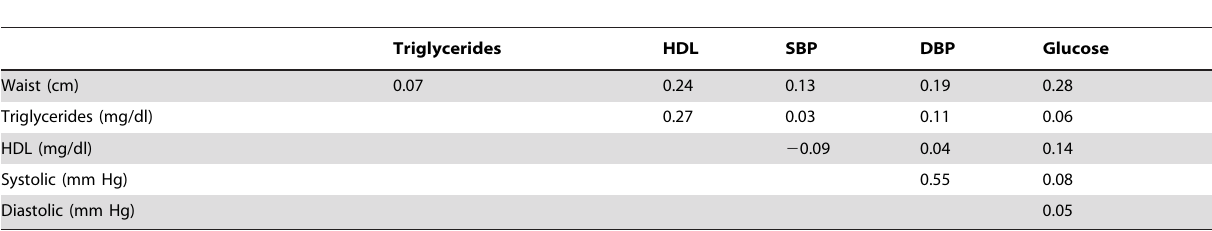
Table 2. Correlations among the component measurements obtained from the pooled within-groups covariance